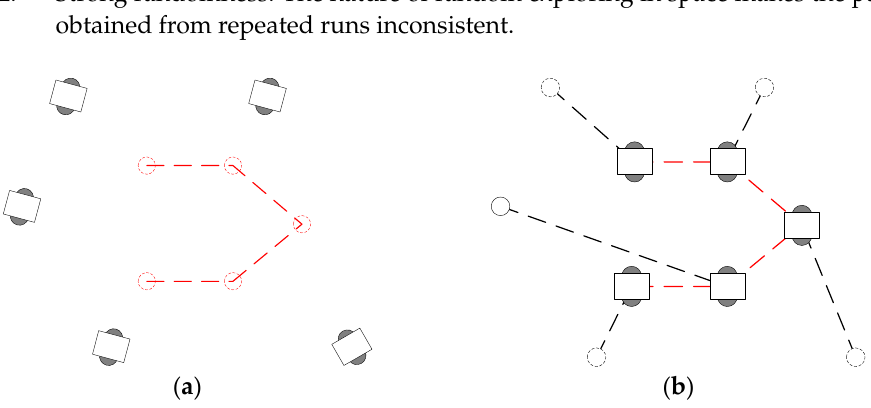
Figure 1. Illustration of the traditional UGV formation control method. In ( a ), set the formation area near the MUVs to facilitate unmanned vehicles to track nodes; in ( b ), the unmanned vehicle tracks the node closest to itself and forms the expected formation. the node closest to itself and forms the expected